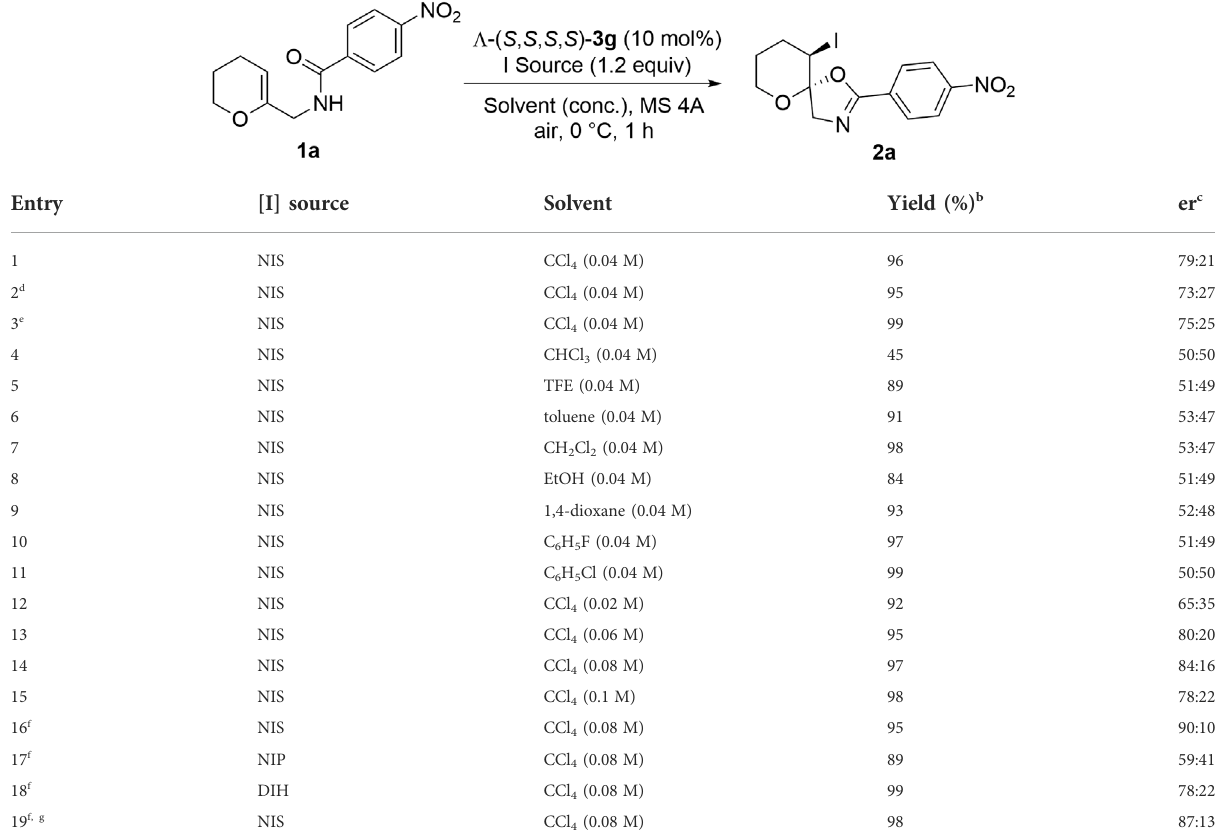
TABLE 2 Optimization of reaction conditions a .